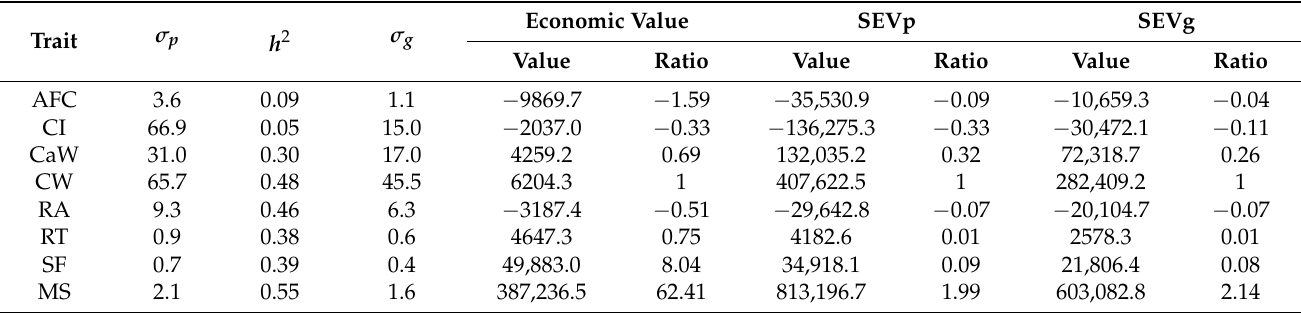
Table 6. Standardized economic values of the traits on the basis of phenotypic standard deviation ( σ p ) (SEVp) and additive genetic standard deviation ( σ g ) (SEVg) 1 .